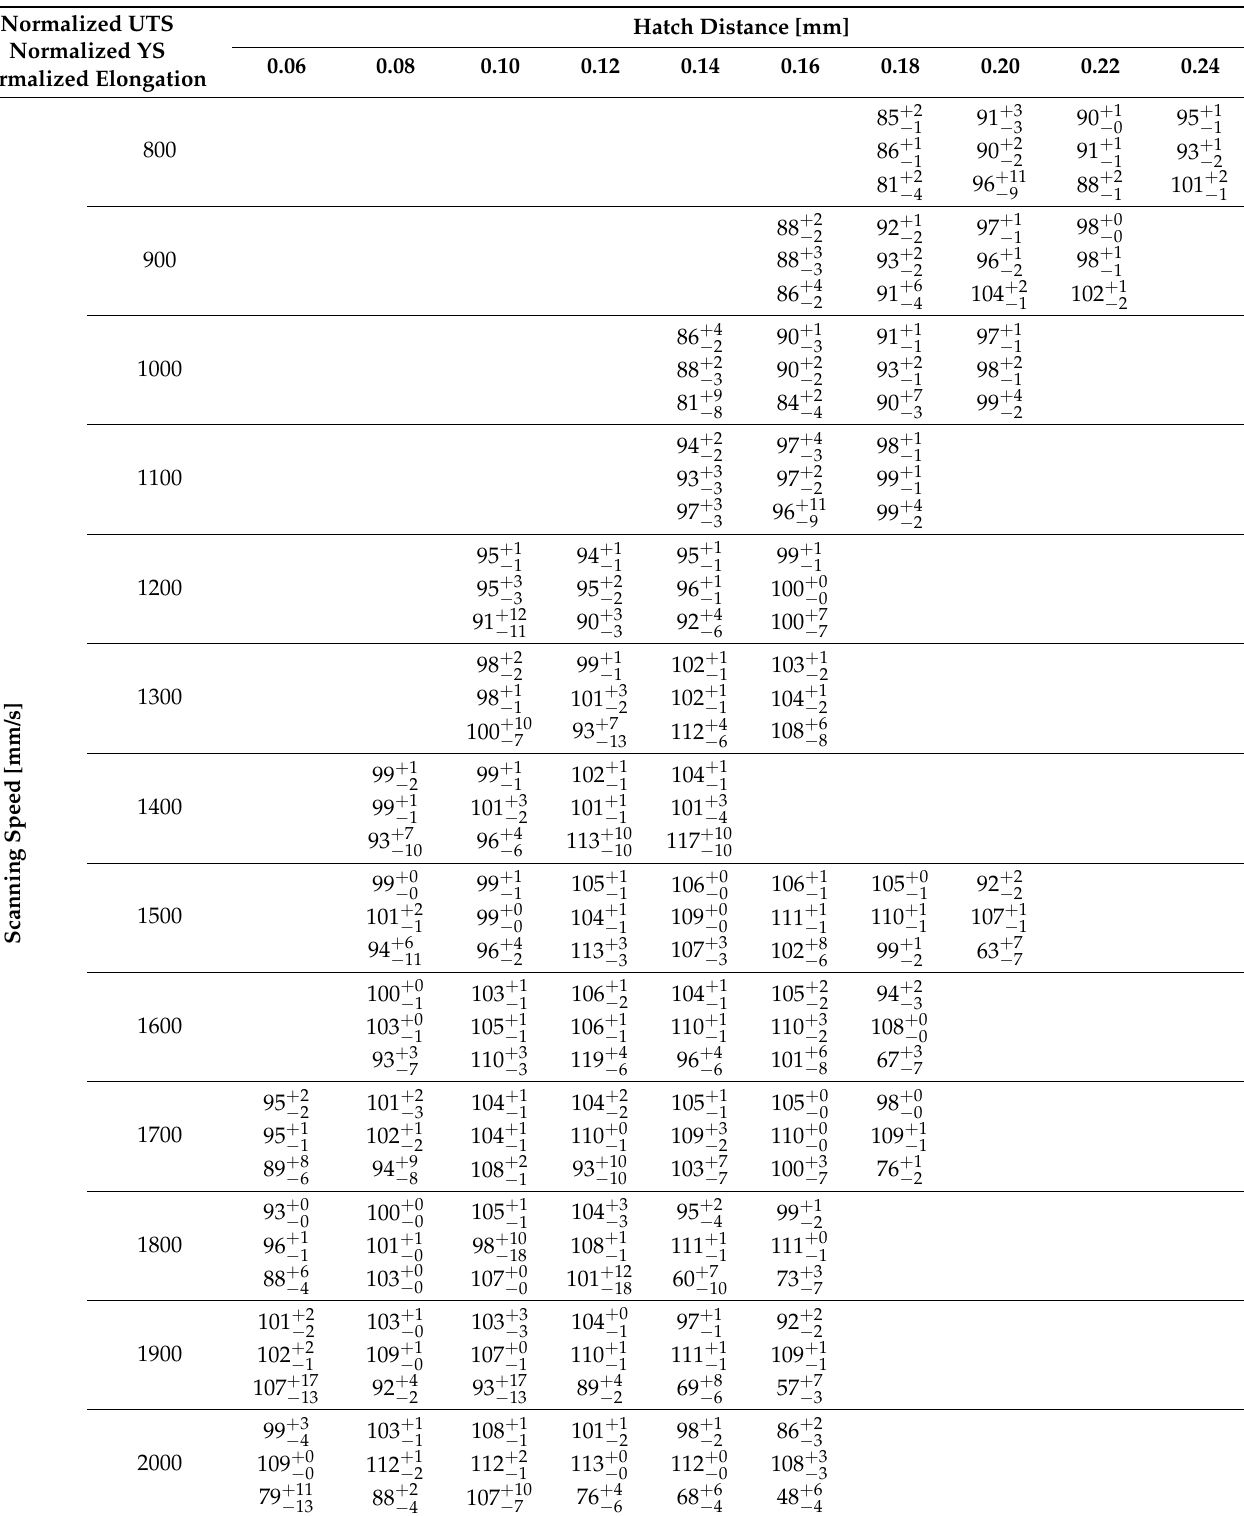
Table 3. Complete set of tensile results. The average values of normalized UTS, normalized YS and normalized elongation are listed together with the range of